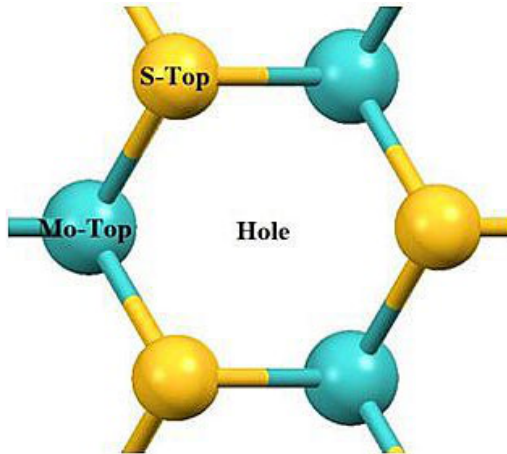
Fig. 3. Three sites of metal atoms adsorbed on MoS H stand for the sites above the S atom, Mo atom and the center of the hexagonal or pentagonal ring of MoS yellow, green and white balls represent S, Mo and metal atoms.